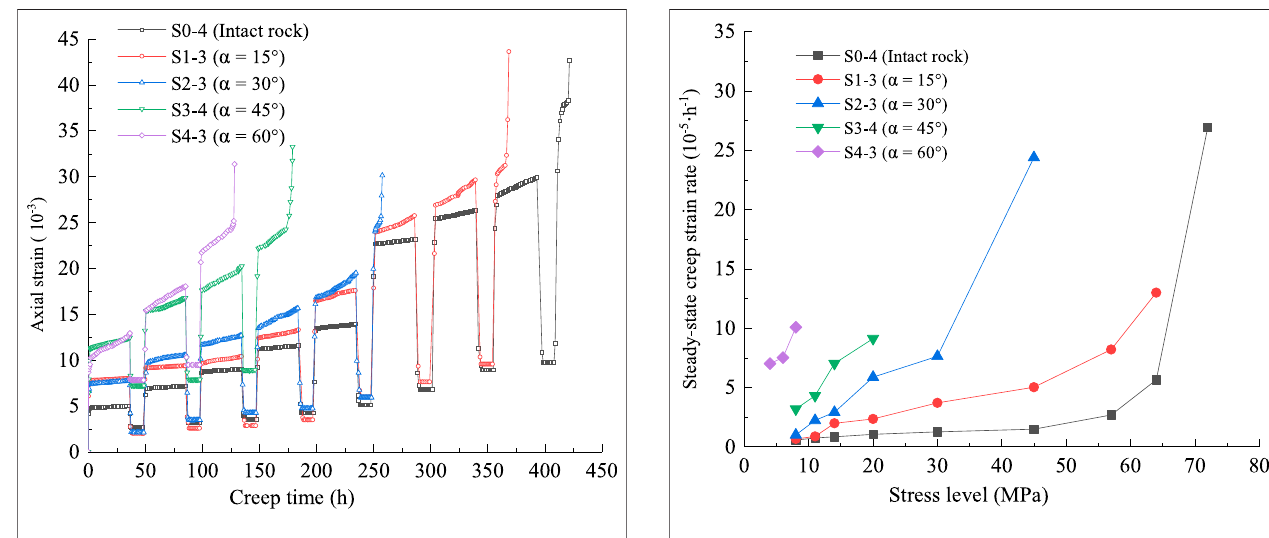
FIGURE10| Steady-statecreepstrainrateofspecimensfromthe fi rstto the last stress